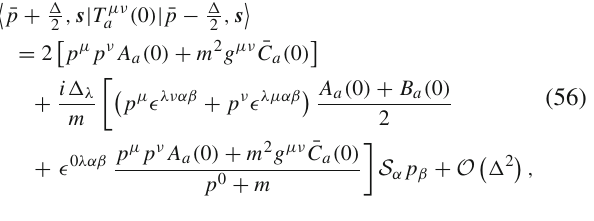
Table 1 Expectation values of the main three position operators and of the corresponding spin operators Relativistic center